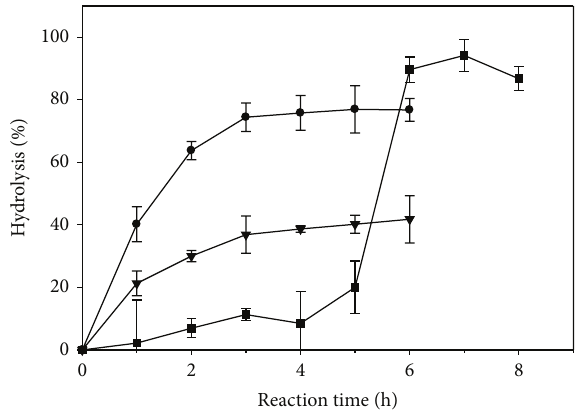
Figure 1: Effect of reaction time on the hydrolysis of 6mM safflower oil, using lipases from Candida rugosa type VII (CRL) ( e ), porcine pancreas type II (PPL) ( 󳶃 ), and Thermomyces lanuginosus (Lipozyme TL IM) ( ◼ ). The biocatalyst amount was 3.3 mg of solid enzyme/mL reaction mixture for CRL and PPL and 3.3 mg of granular enzyme/mL reaction mixture for Lipozyme TL